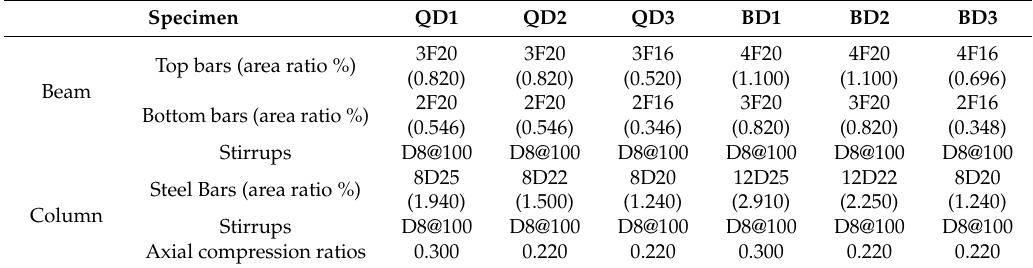
Table 2. Layout of test specimens.